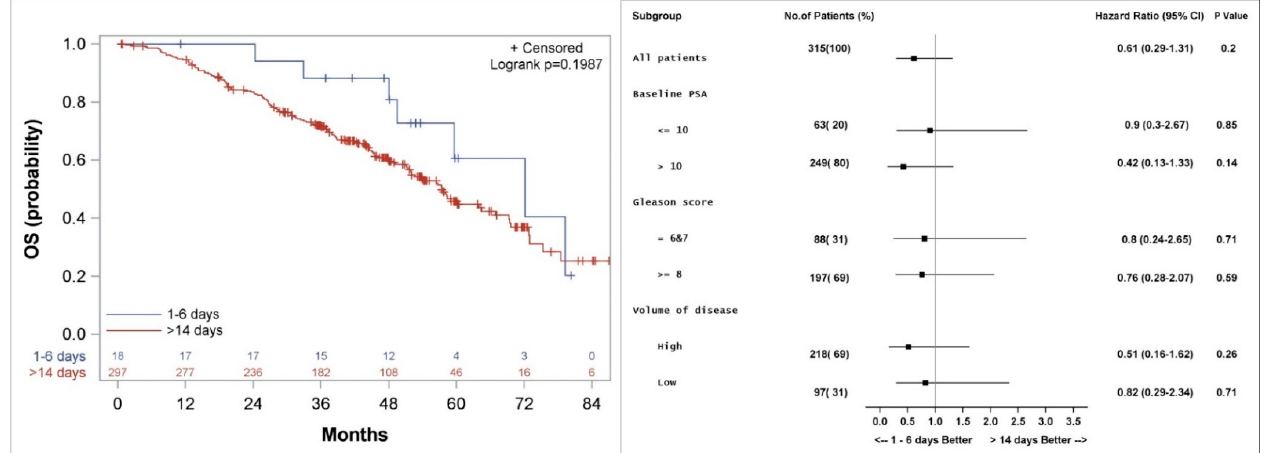
Figure 3. Kaplan–Meier curve ( left ), and subgroup analysis ( right ) for overall survival (OS) for patients who started the first course of docetaxel 1–6 days, compared to more than 14 days after the initiation of LHRH agonist.